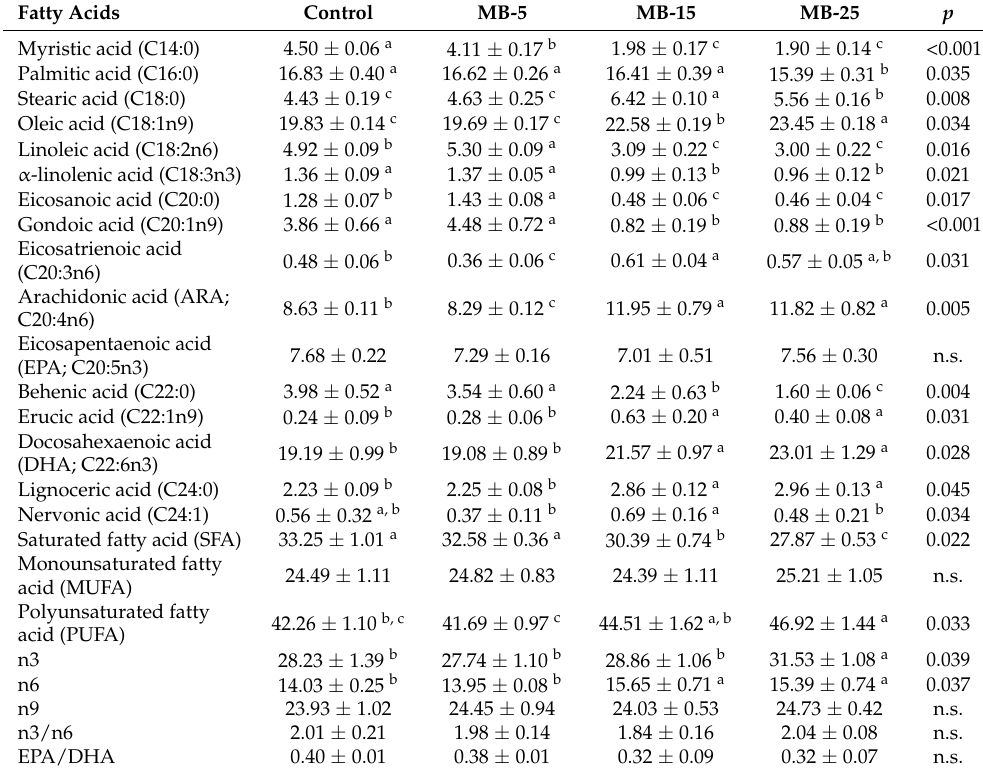
Table 6. Muscle fatty acid composition (% fatty acids) of juvenile S. aurata fed experimental diets for 30